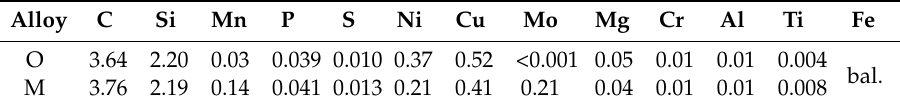
Table 1. Chemical compositions (wt %) of the ductile cast iron alloys